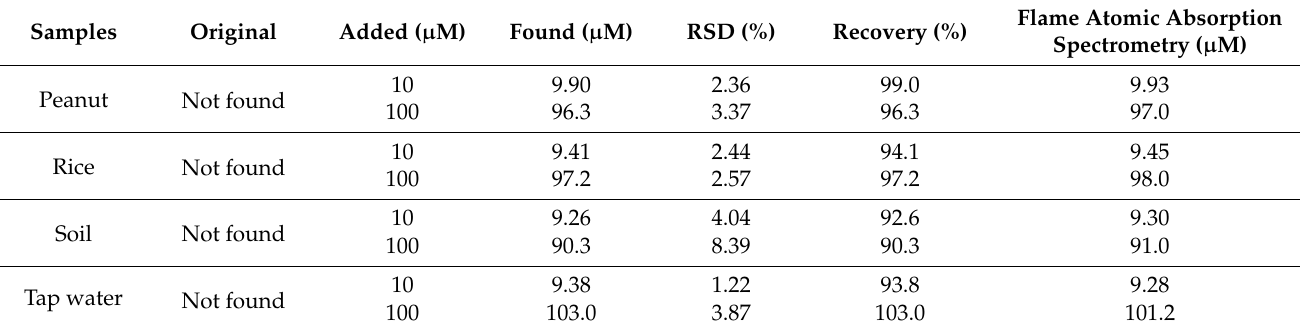
Table 2. Cr(VI) detection results for a real sample using the PEC sensor (n =